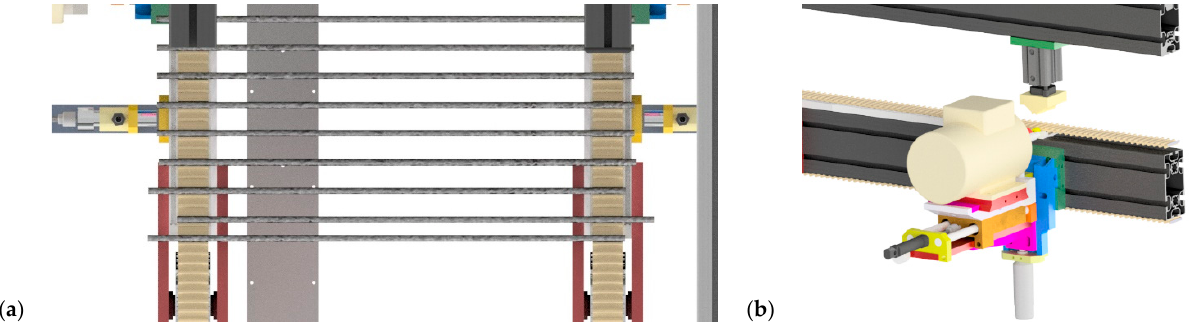
Figure 19. Alignment of spirals before and after the control positioner ( a ) and inside and outside cleaning station ( b ).